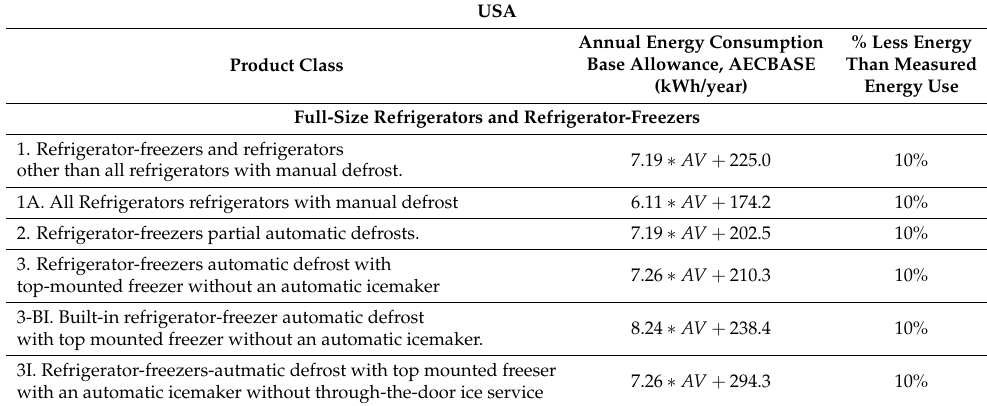
Table 8. Energy consumption in the United States by type of refrigerator, adapted from